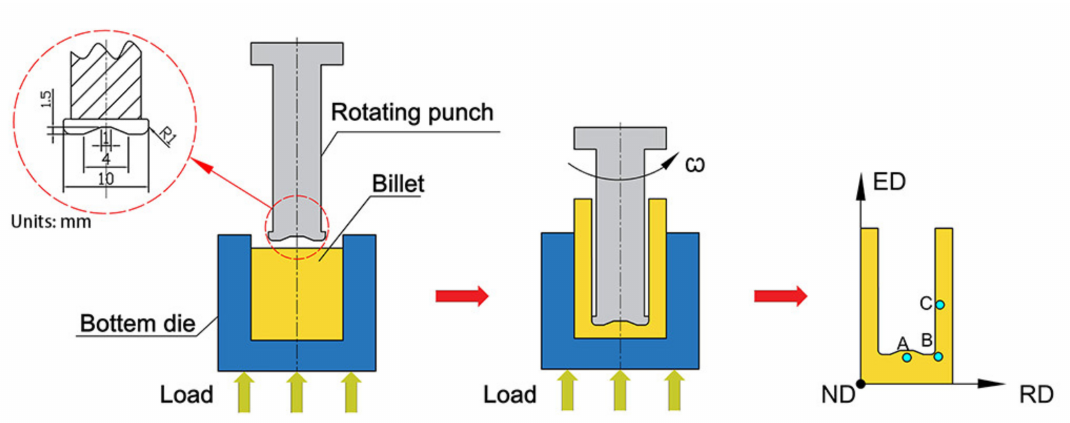
Figure 1. Schematic illustration and microstructure observation position of the rotating backward extrusion (RBE)